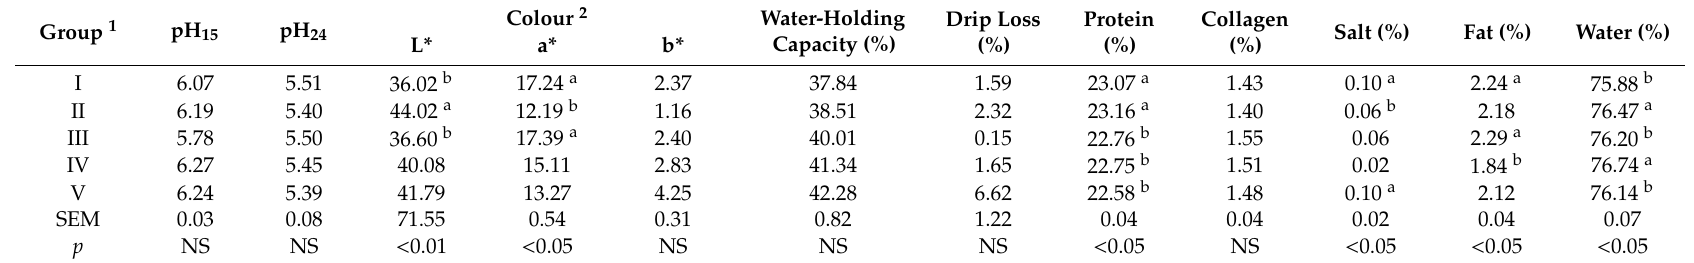
Table 7. Carcass pH and physicochemical parameters of breast muscles in meat